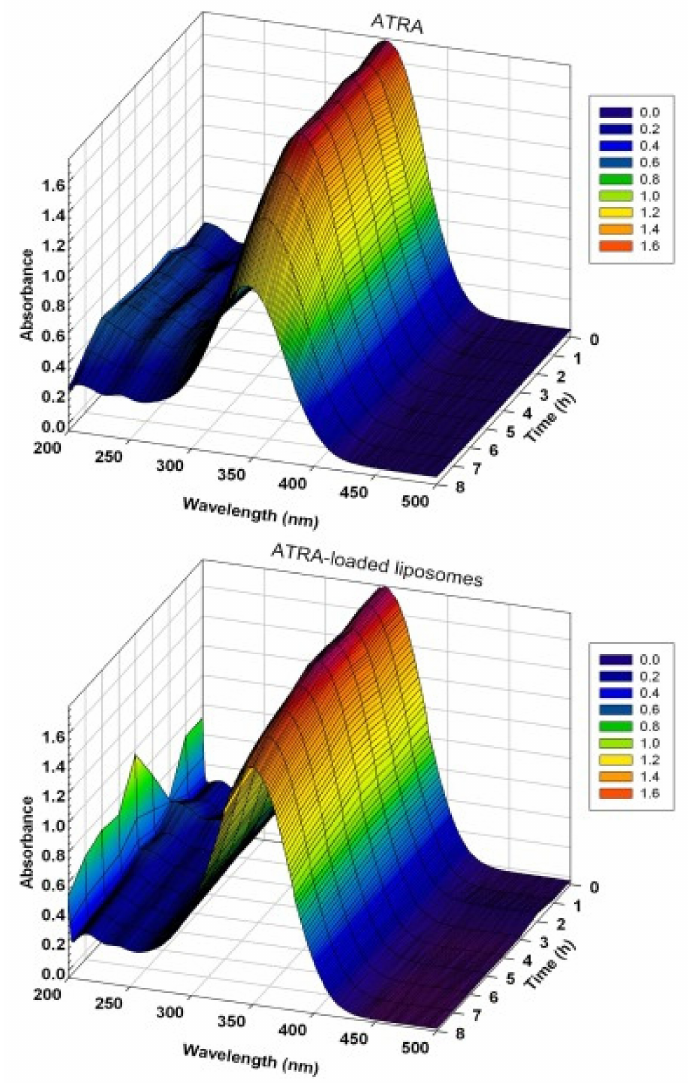
Figure 4. Photostability of all-trans retinoic acid in free form and entrapped within liposomes as a function of the duration of UV-exposition (h). Reprinted with permission from [107]. Copyright © 2017 Elsevier